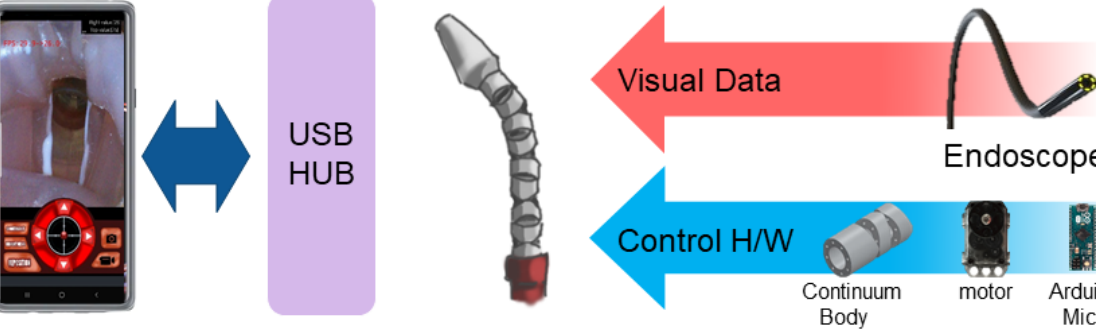
Figure 1. Overall schematic of the data flow of the articulating mobile endoscope. The smartphone is attached to the articulating module, which is a combination of the endoscope module and the continuum